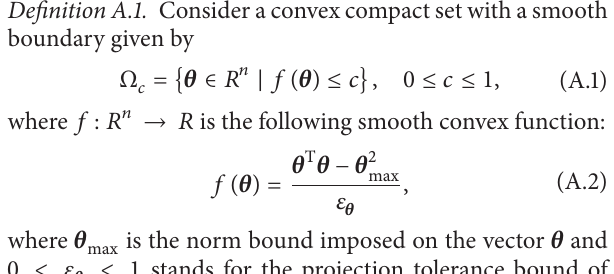
to within [4 deg ., 5.5 deg .] . The responses of the